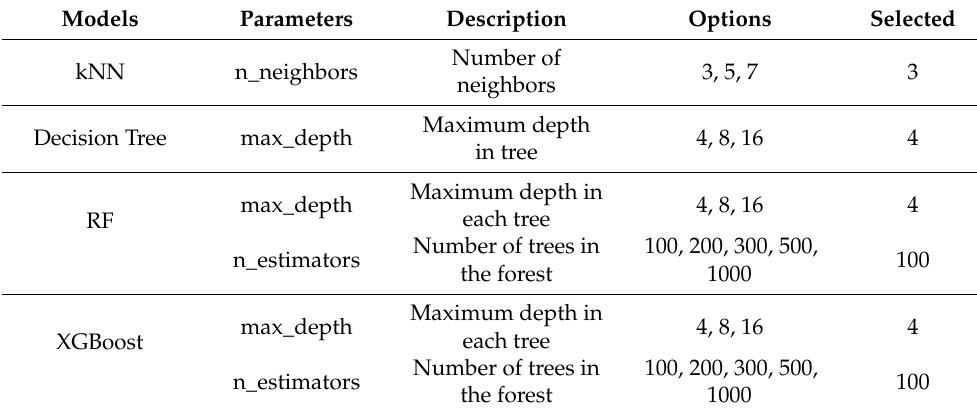
Table 2. Hyperparameters of machine learning models.